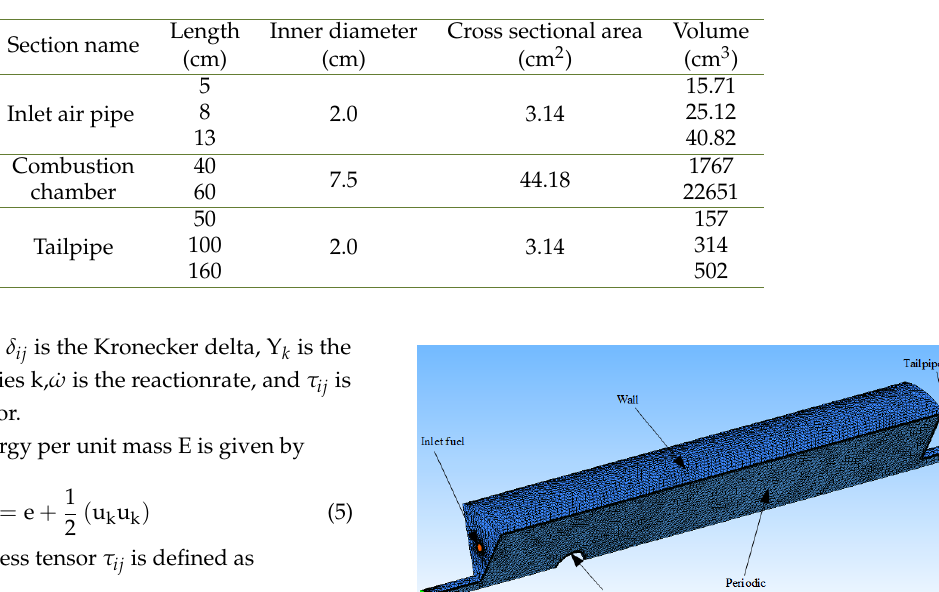
Table 1. The tested geometries of components of the pulse combustor